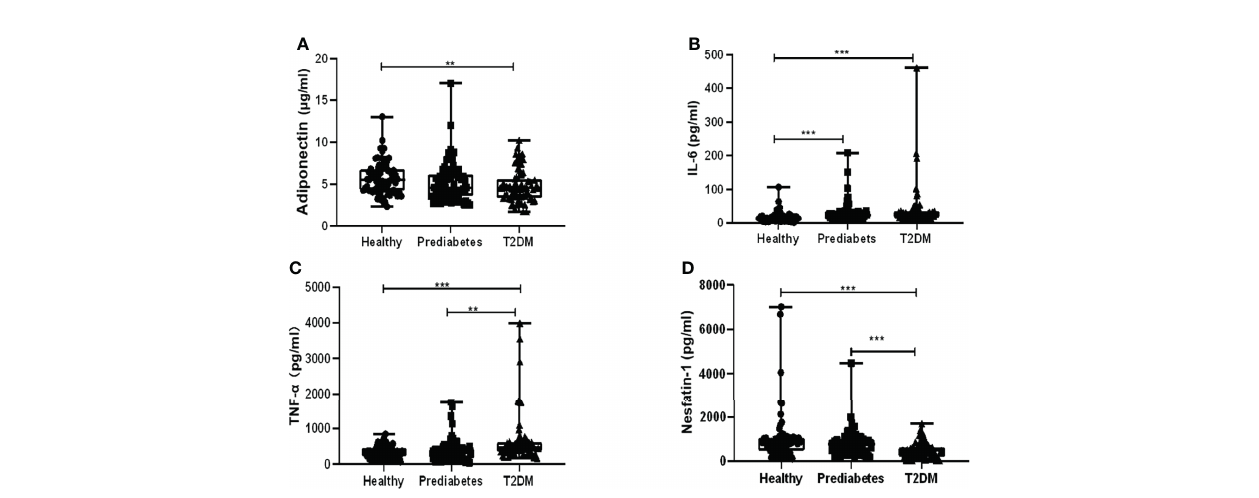
FIGURE 1 | Comparison of serum levels of adiponectin, interleukin 6 (IL-6), tumor necrosis factor a (TNF- a ), and nesfatin-1 among type 2 diabetes mellitus (T2DM), prediabetes, and the healthy. (A) Adiponectin levels in T2DM signi fi cantly decreased compared with those in the healthy other than prediabetes, while no apparent difference was observed between T2DM and prediabetes. (B) IL-6 levels in T2DM or prediabetes were dramatically increased in contrast to those in the healthy, while no signi fi cant variation was displayed between the prediabetes and T2DM. (C) Profound elevation of TNF- a in T2DM was found compared with prediabetes or the healthy group, but it showed an insigni fi cant rise when comparing prediabetes with healthy. (D) Nesfatin-1 levels in T2DM were dramatically declined in contrast to those in the healthy or prediabetes, while no signi fi cant reduction was presented when comparing prediabetes with the healthy. ** vs. Healthy P < 0.01, *** vs. Healthy P < 0.001.